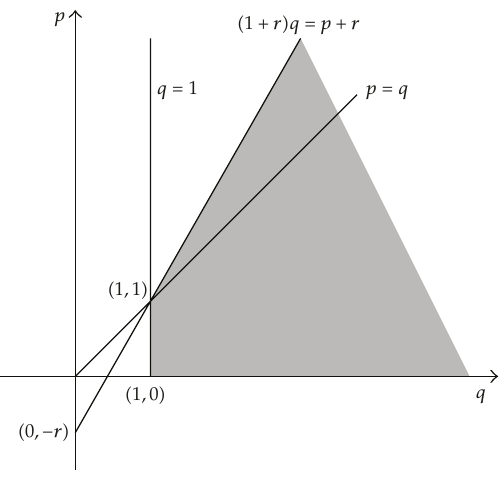
Figure 1: Domain of Furuta